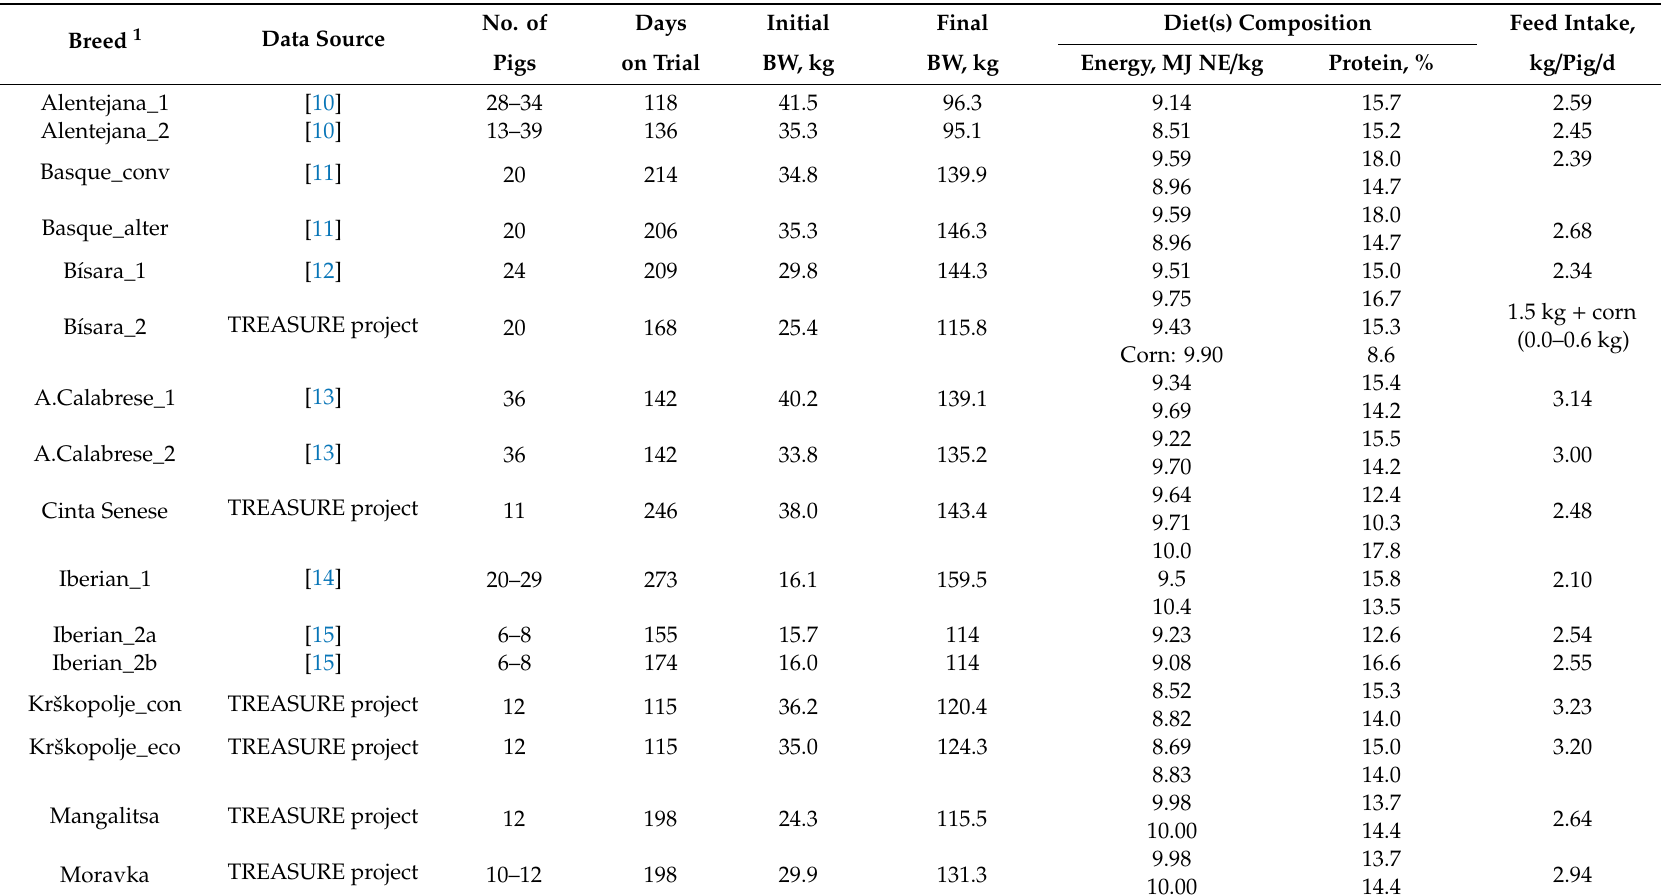
Table 1. Summary of studies selected for modelling study on local breeds (diet composition and feed intake expressed on an as-fed basis). BW: body weight; NE: net